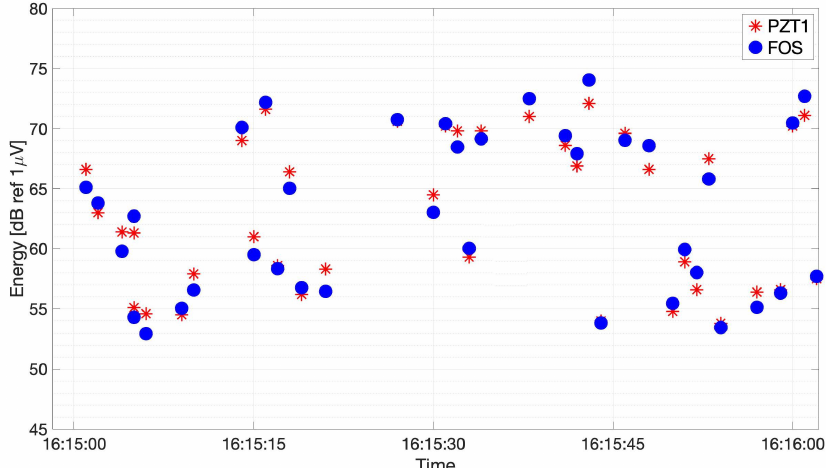
Figure 13. The evaluated energy during 1 min of the fatigue growth crack test at L = 15 mm crack